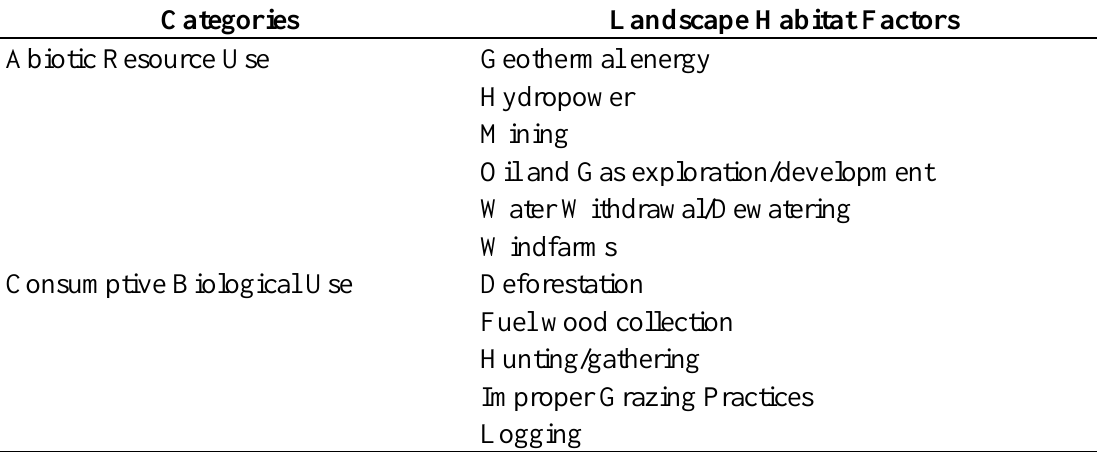
Table 4. List of factors affecting habitats by category.